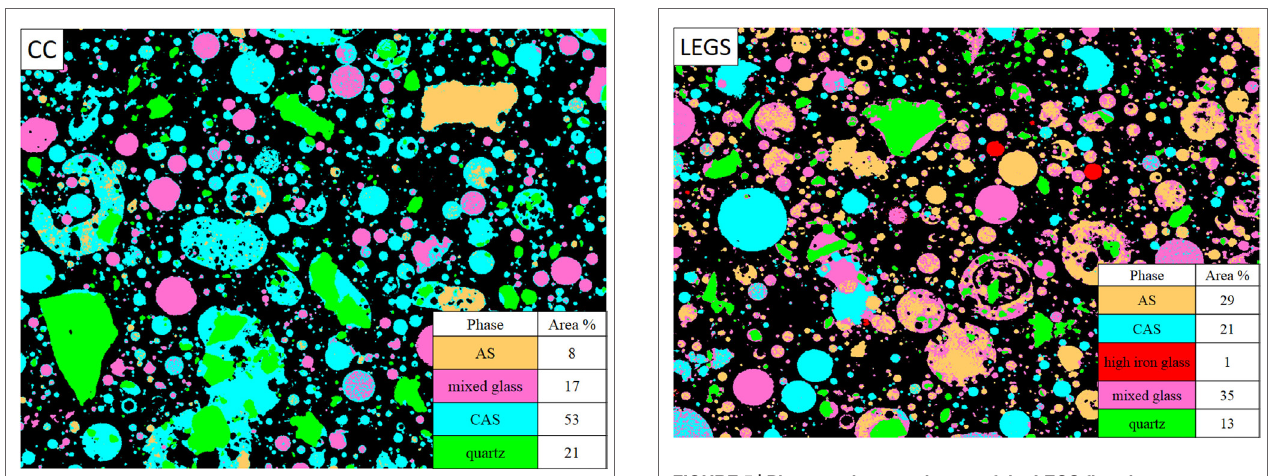
FigUre 5 | Phase assignment image of the legs fly ash.